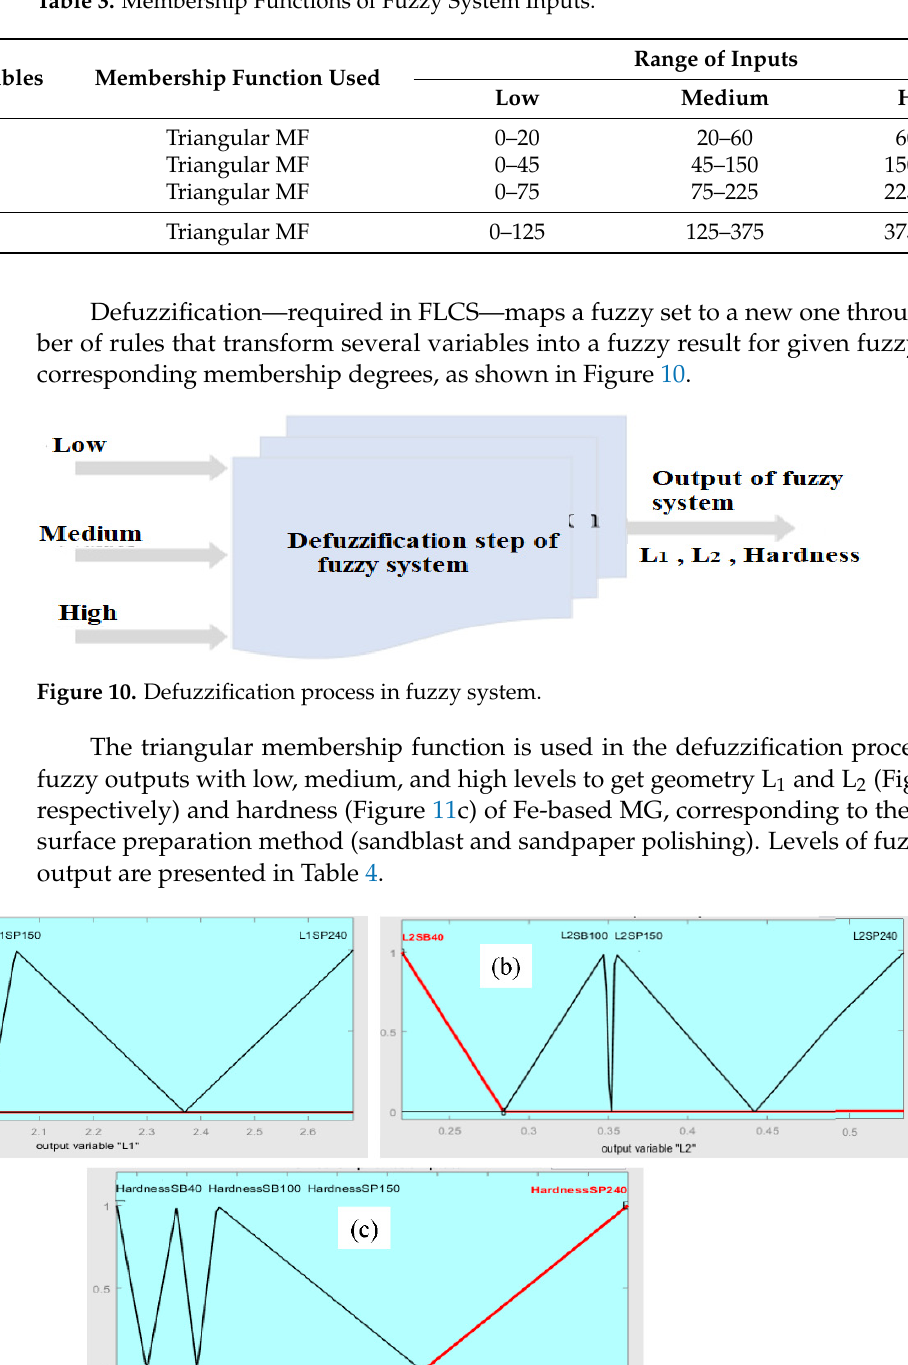
( c ) SP 150, and ( d ) SP 240.